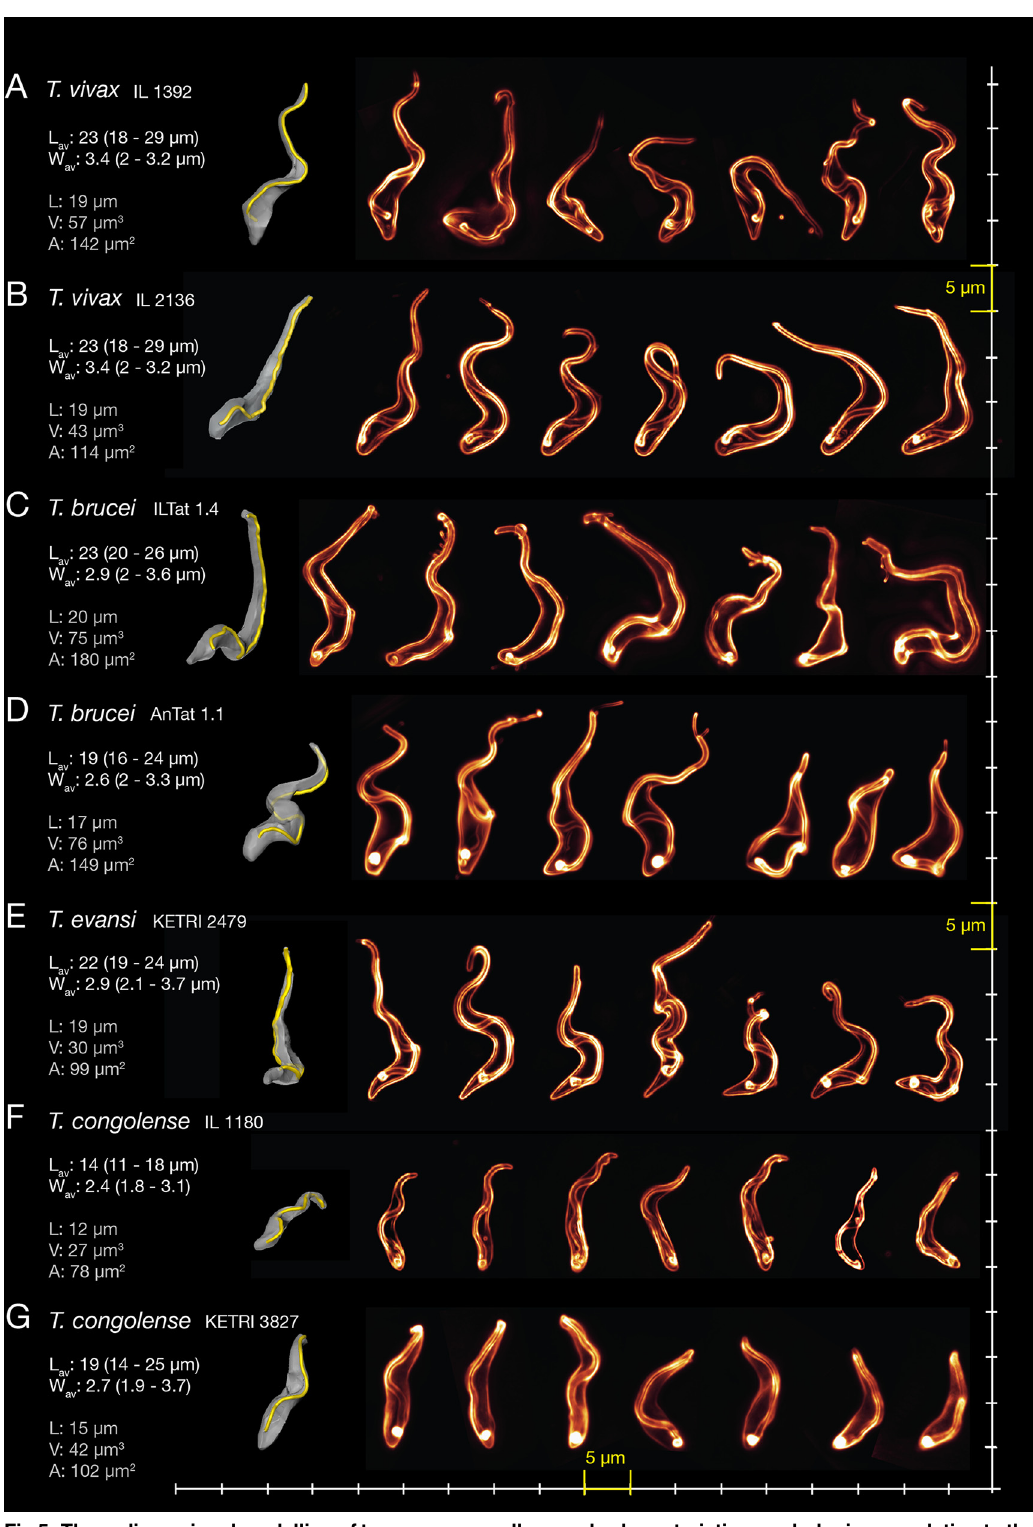
Fig 5. Three-dimensional modelling of trypanosome cells reveals characteristic morphologies correlating to the species-specific motility behaviour. The parasites were harvested from infected mice and the cell surface was fluorescently labelled with sulfo-NHS dyes. On the left of each panel representative surface-rendered models of fluorescently surface-labelled trypanosome cells are shown. The fluorescence labelling allows the simultaneous